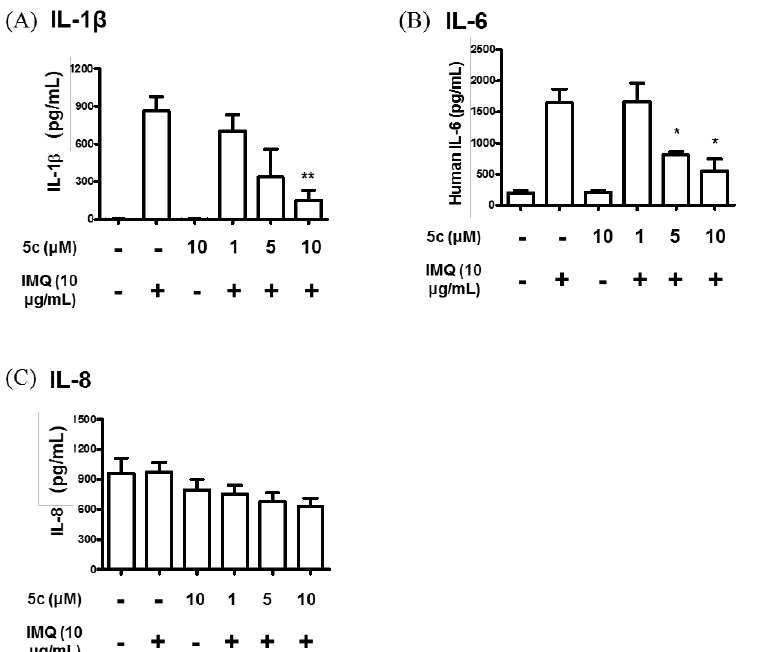
Figure 3. Effect of 5c on inhibition of inflammatory cytokines in differentiated HaCaT cells was done by ELISA ( A ) IL-1 β , ( B ) IL-6 and ( C ) IL-8. The cells were incubated with IMQ alone, IMQ with different concentrations of 5c in media containing 2% fetal bovine serum (FBS) for 24 h at 37 ◦ C. Data are presented as mean ± SD ( n =